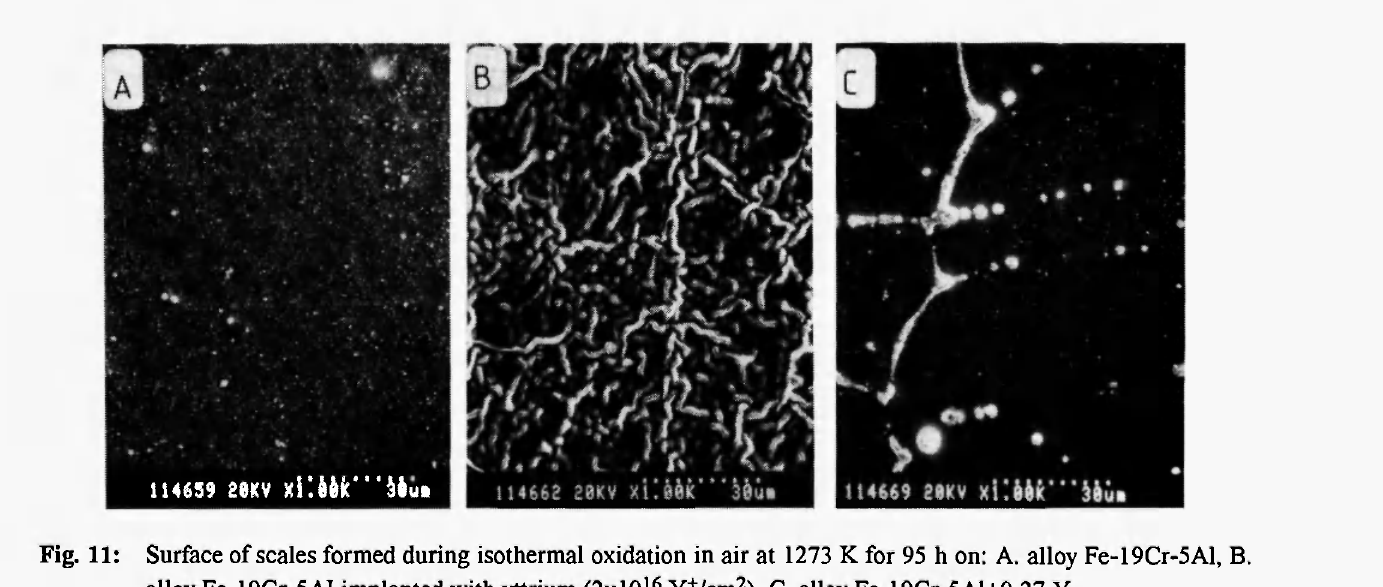
Fig. 11: Surface of scales formed during isothermal oxidation in air at 1273 Κ for 95 h on: A. alloy Fe-19Cr-5Al, B.